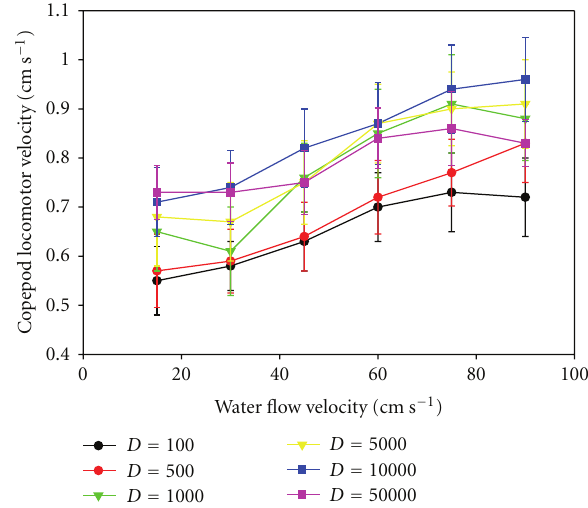
Figure 6: Copepod ( Calanus ) locomotor velocity (mean, N = 35; error bars = 1SD) in “still” tank, measured at varying distance from closest point of baleen moving at 30–90 cm s − 1 , in light (at 22 degrees C).